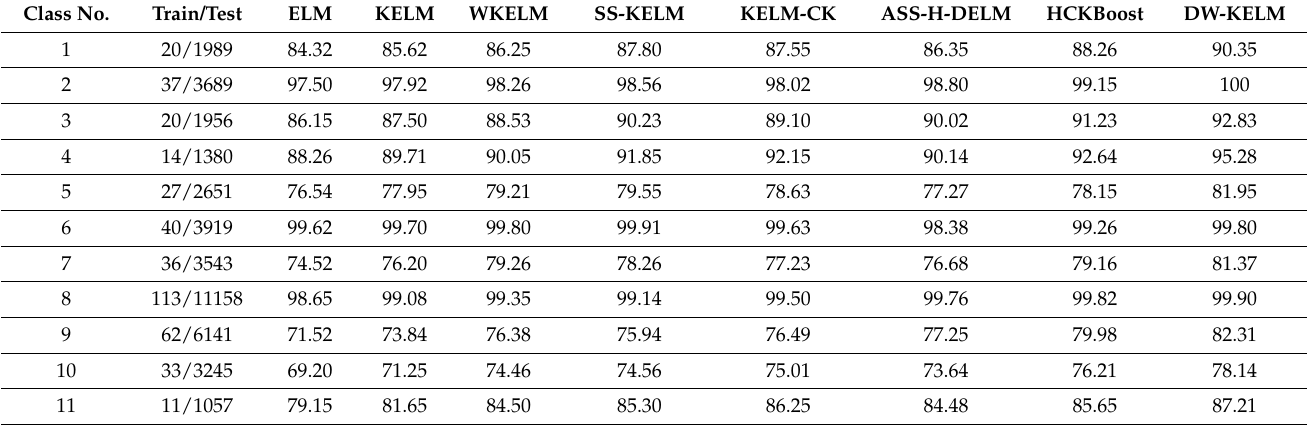
Table 5. OA, AA, and kappa (%) obtained by different approaches on the Salinas data set. Class